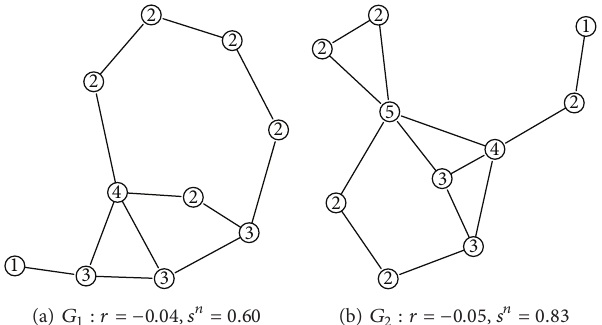
Figure 1: Two example graphs with 𝑛 = 10 nodes and 𝑚 = 12 edges (a) and 𝑛 = 10 nodes and 𝑚 = 13 edges (b) with the degrees inside the